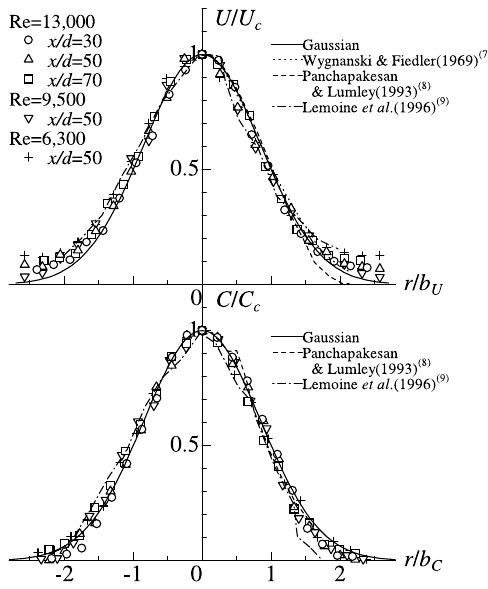
Fig. 3 Radial profiles of mean velocity and the concentration across the